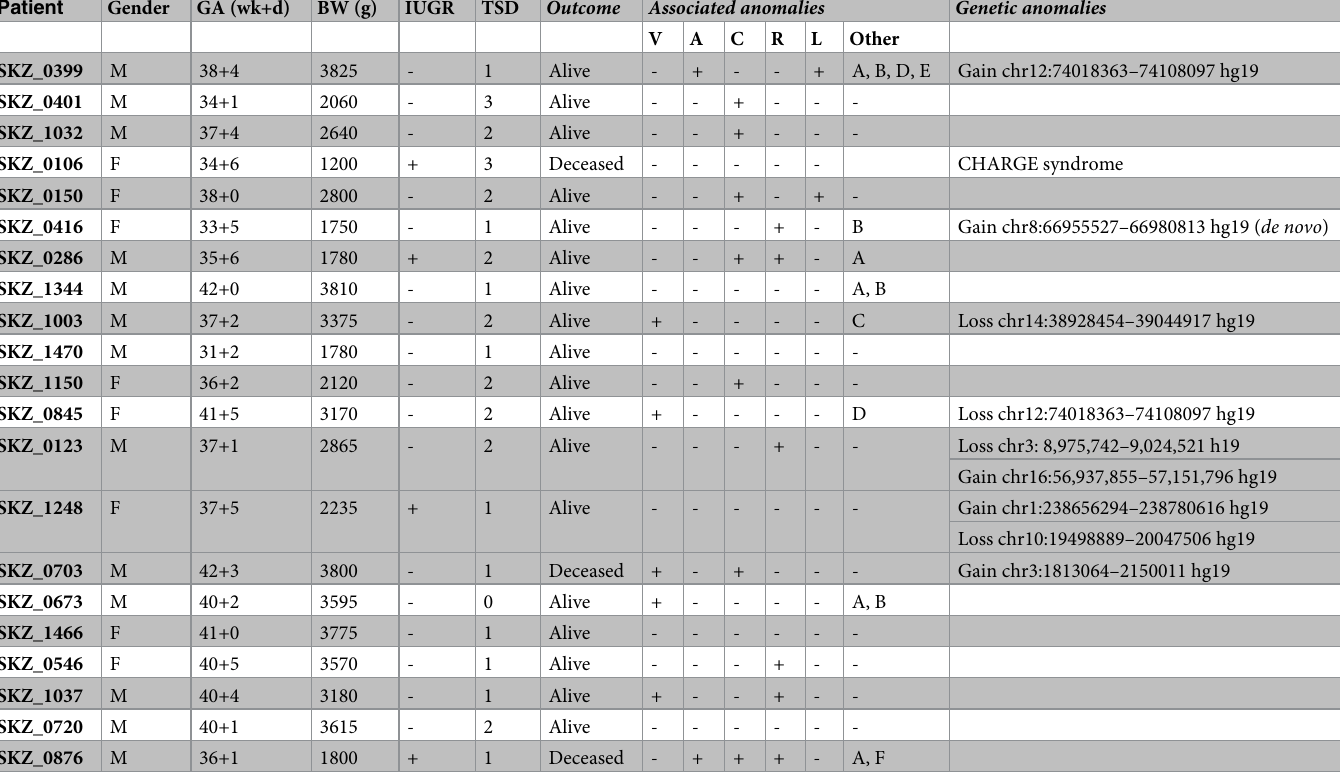
Table 1. Patient